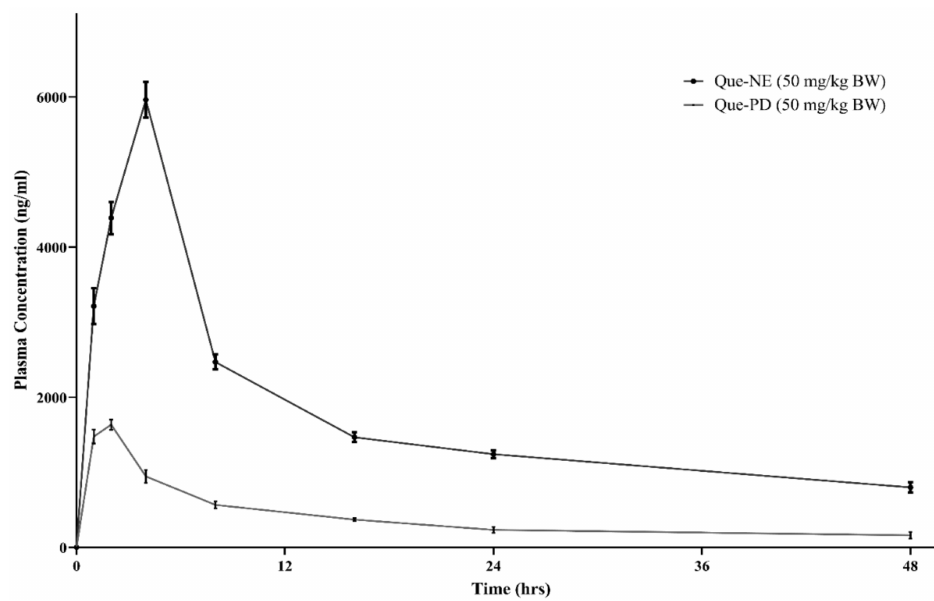
Figure 6. Plasma concentration–time profile of optimized Que-NE and